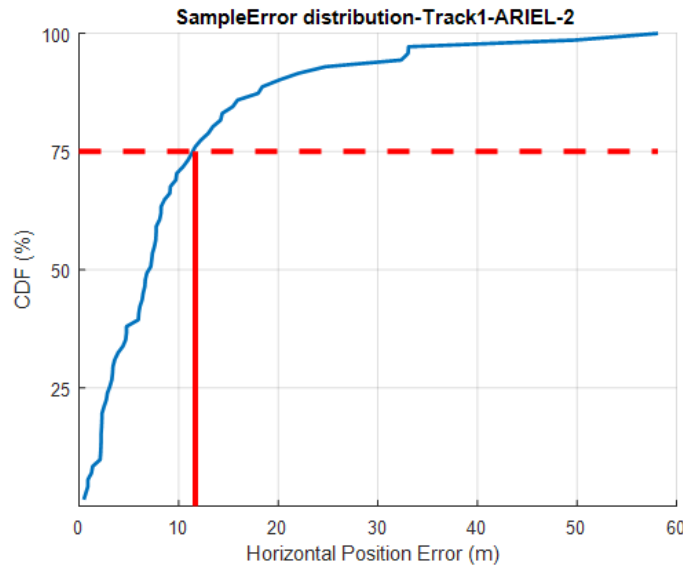
Figure 18. STEPS system sample error distribution, measured at the Microsoft Indoor Localization Competition.